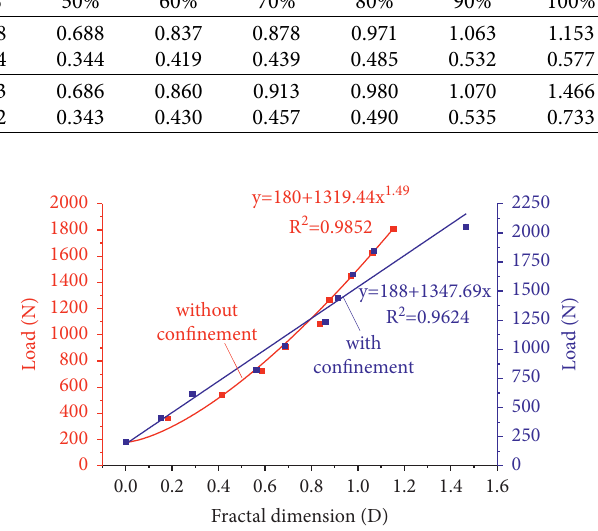
Figure 14: Relationship between diametral load and fractal di- mension under different loading levels.